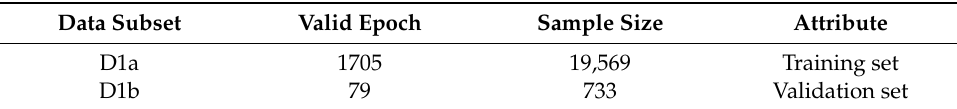
Table 2. Valid epoch and sample size of D1a and